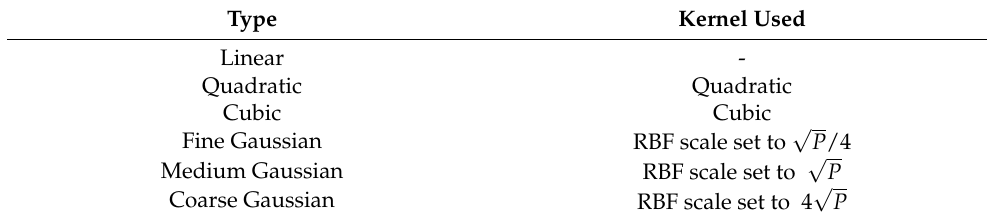
Table 2. Types of SVM and their kernels